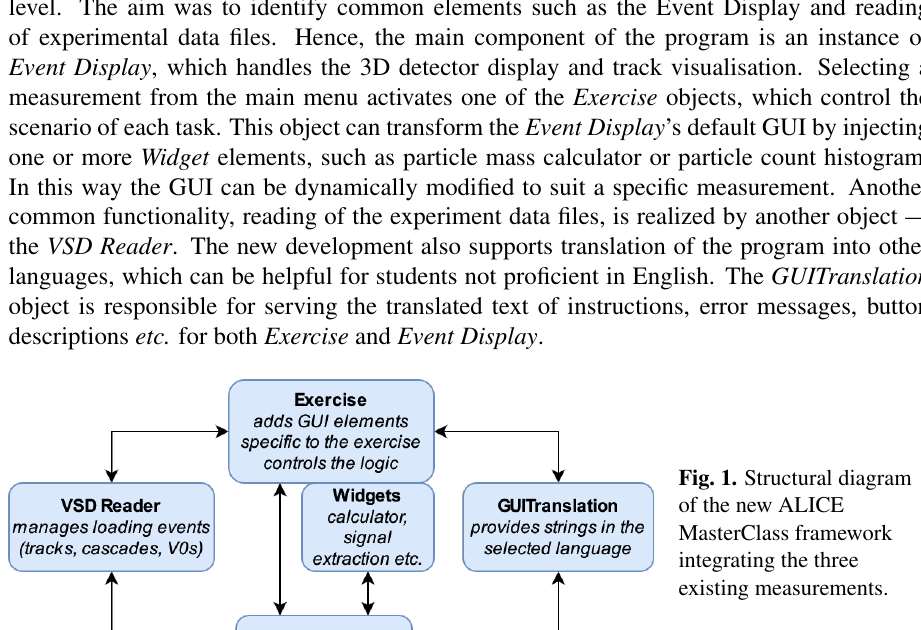
Fig. 1. Structural diagram of the new ALICE MasterClass framework integrating the three existing